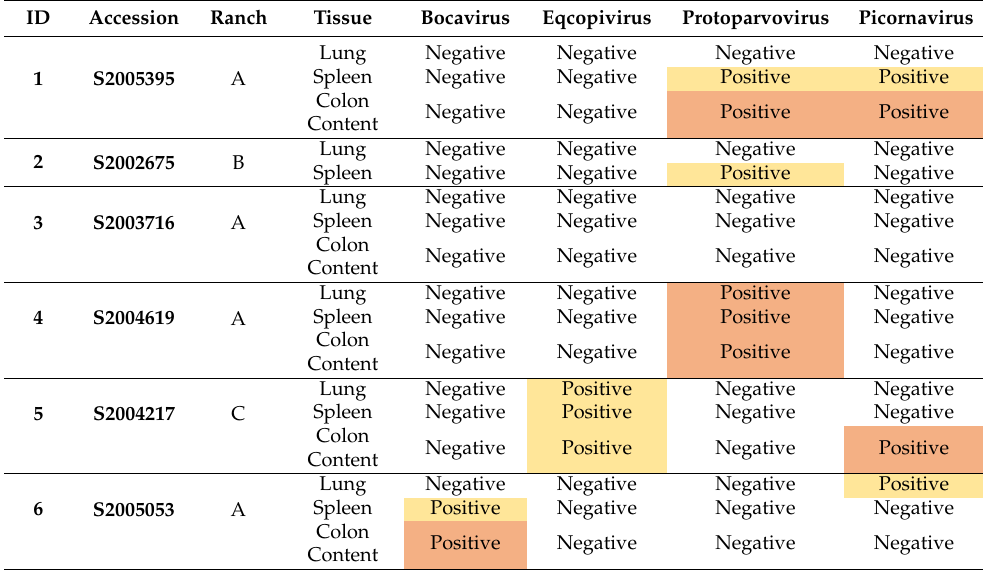
Cells in orange indicate first and nested PCR both positive. Cells in yellow indicate only second round nested PCR